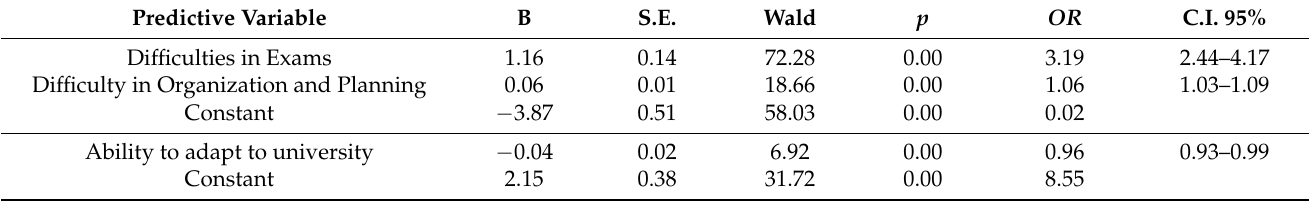
Table 2. Results derived from binary logistic regression for the probability of being a victim of cyberbullying. Predictive Variable